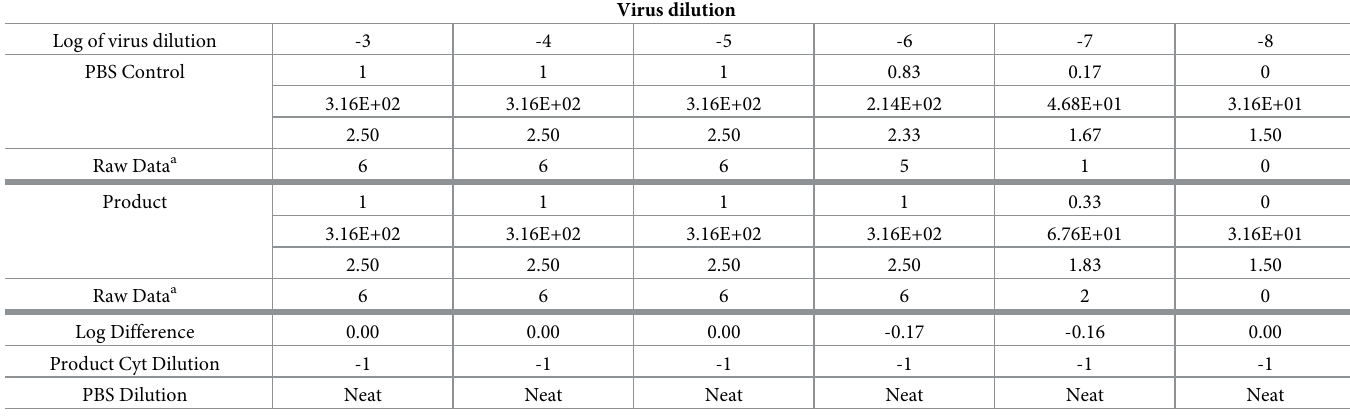
Table 6. Interference